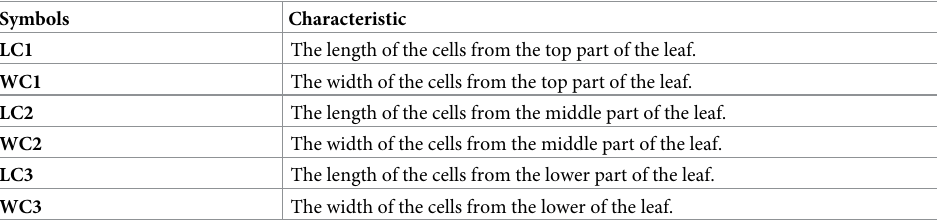
Table 1. The measured features and their